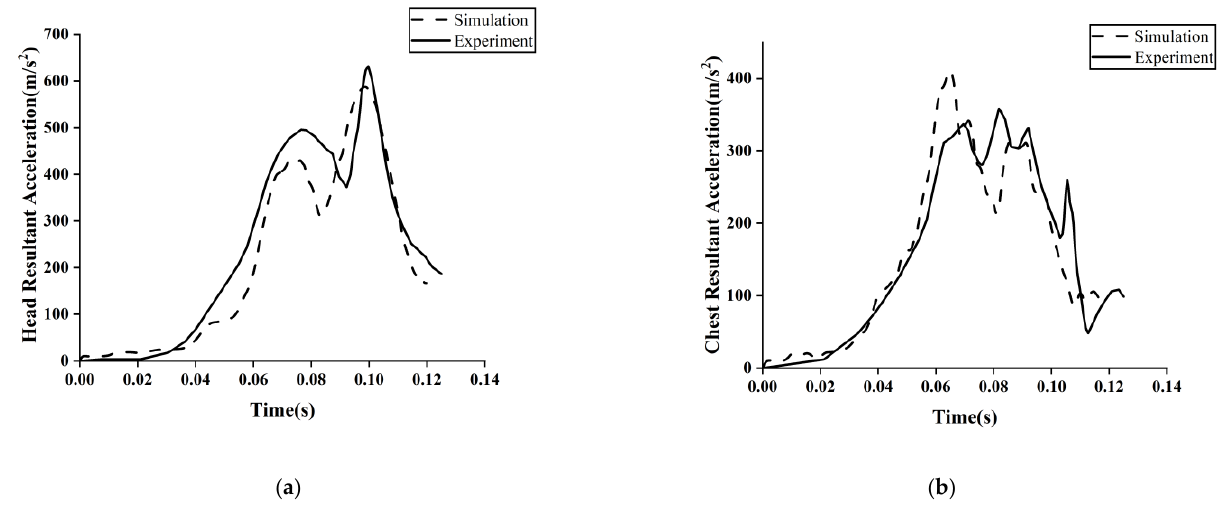
Figure 3. Comparison of child dummy kinematics between simulation and test: ( a ) t = 30 ms; ( b ) t =